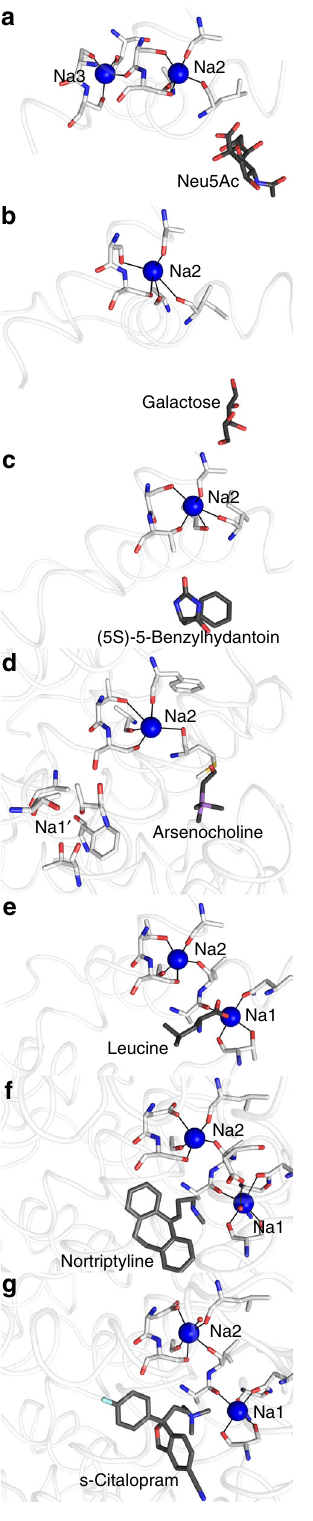
Fig. 5 Sodium and substrate binding sites of Na + transporters that adopt the LeuT fold. a SiaT (outward-open, pdbid: 5NV9), b vSGLT (inward-open, pdbid: 3DH4), c Mhp1 (outward-occluded, pdbid: 4D1B), d BetP